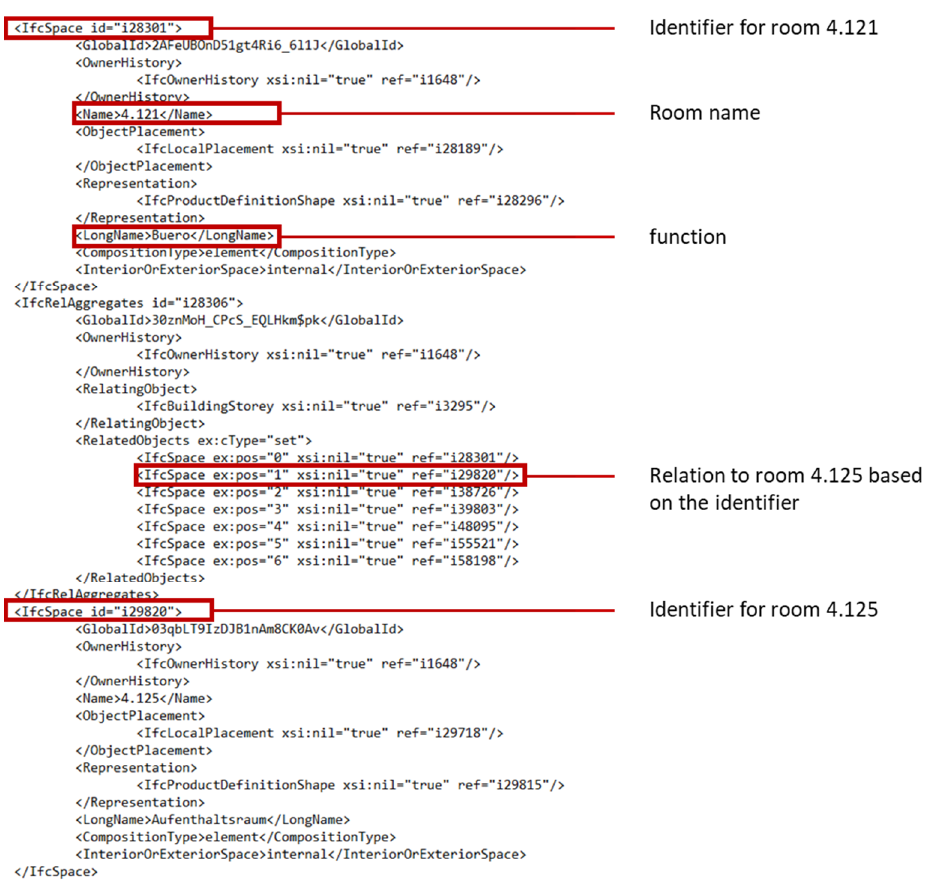
Figure 8. Extract of the XML schema showing the relationship between IfcSpaces.